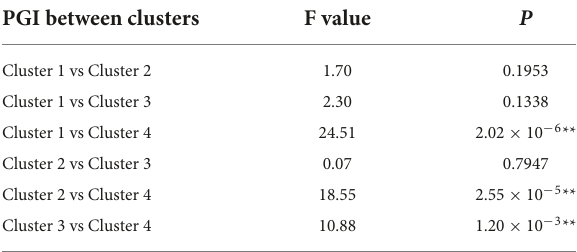
Shown P -valuesarebeforeBonferronicorrections.Toaccountforcorrections,thresholds issetat P < 1.67 × 10 − 3 tobeconsideredhighlysignificant(indicatedby**).